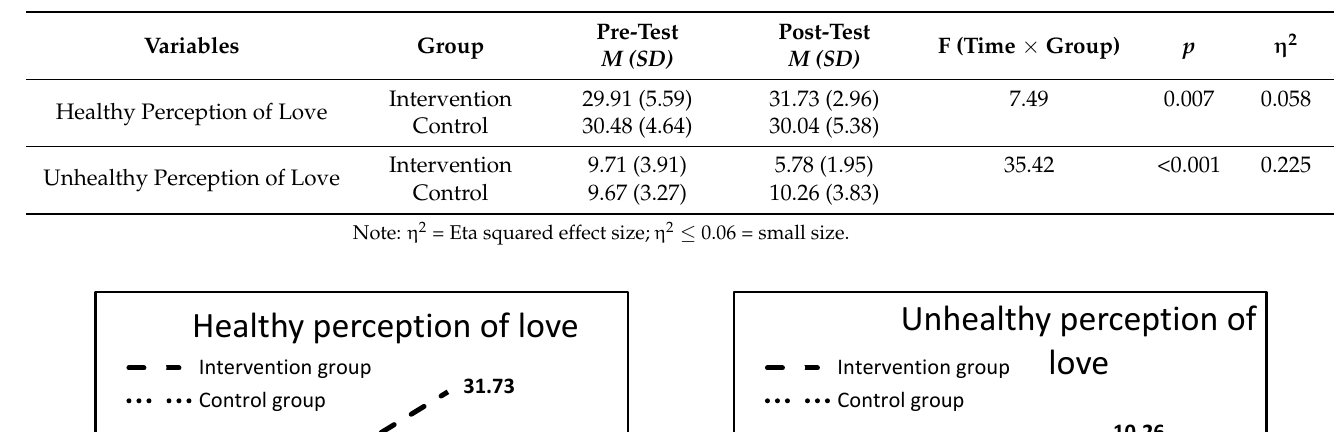
Table 1. Between-group effects and repeated measures analysis of variance (ANOVA 2 × 2) in adolescents’ perceptions of love.